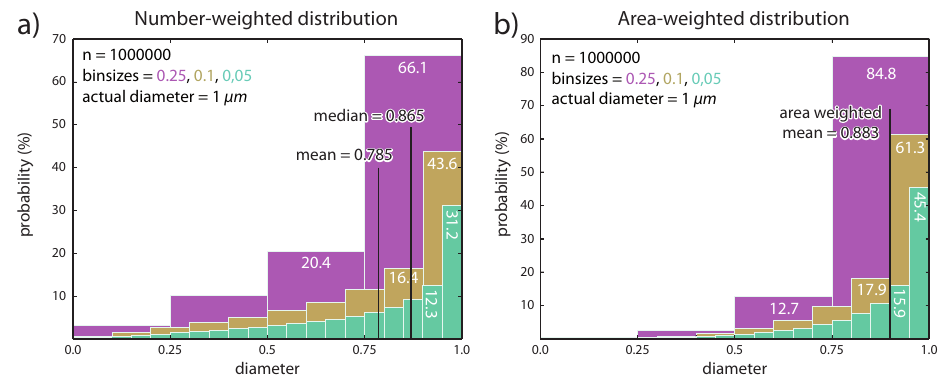
Figure 2. Grain size distribution plots produced by cutting a sphere of the same size randomly (monodisperse system). (a) Histogram of apparent diameters from a population of spheres of size 1 showing different number of classes or bin sizes. The actual diameter of the grain is always within the most frequent class of the histogram, the modal interval – in fact, in its upper limit. The mean and the median grain size of the population is always respectively 0.785 and 0.865 times the actual grain size for a representative sample size. (b) Same population as (a) but a bar plot showing the area percentages of equivalent diameters (i.e. the sum of the areas of the grains with respect to the total for each grain size interval defined). The area-weighted mean of the population is 0.88 times the actual grain size for a representative sample size.